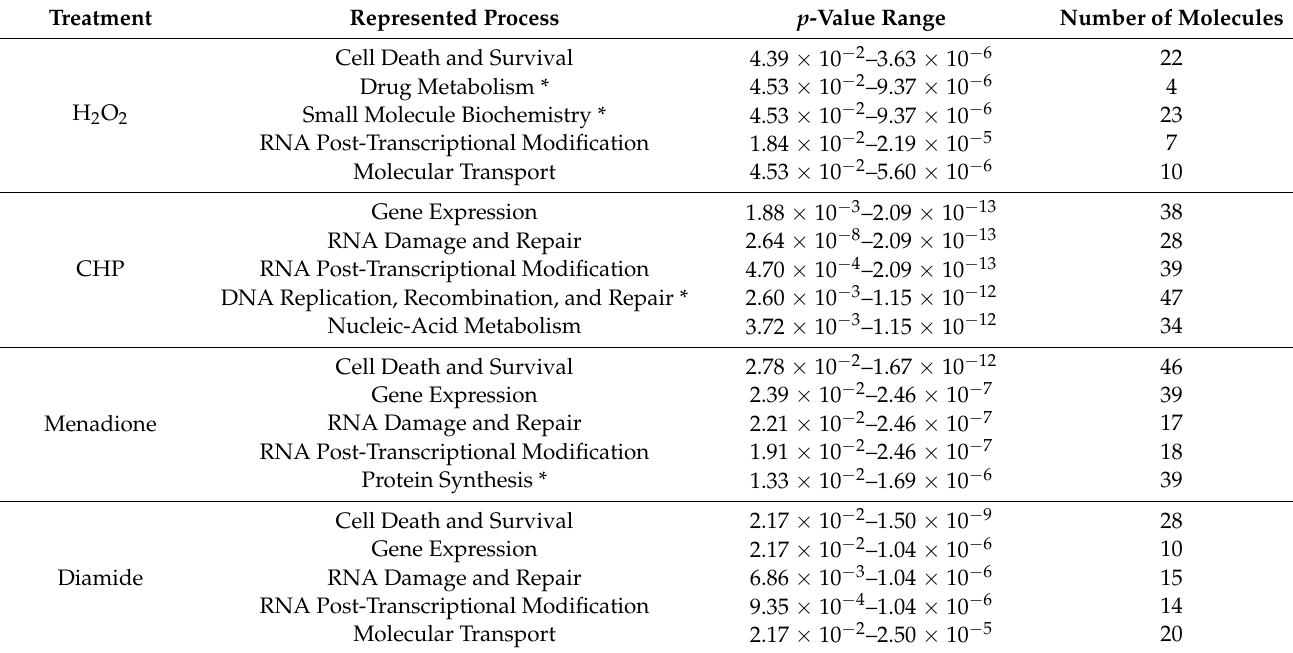
Table 1. Top five molecular and cellular functions represented by Ingenuity Pathway Analysis ® (IPA ® ) using significantly regulated proteins identified by label-free quantitative proteomics performed in S. cerevisiae strains treated with the chosen four different oxidants. Asterisks (*) indicate unique molecular and cellular